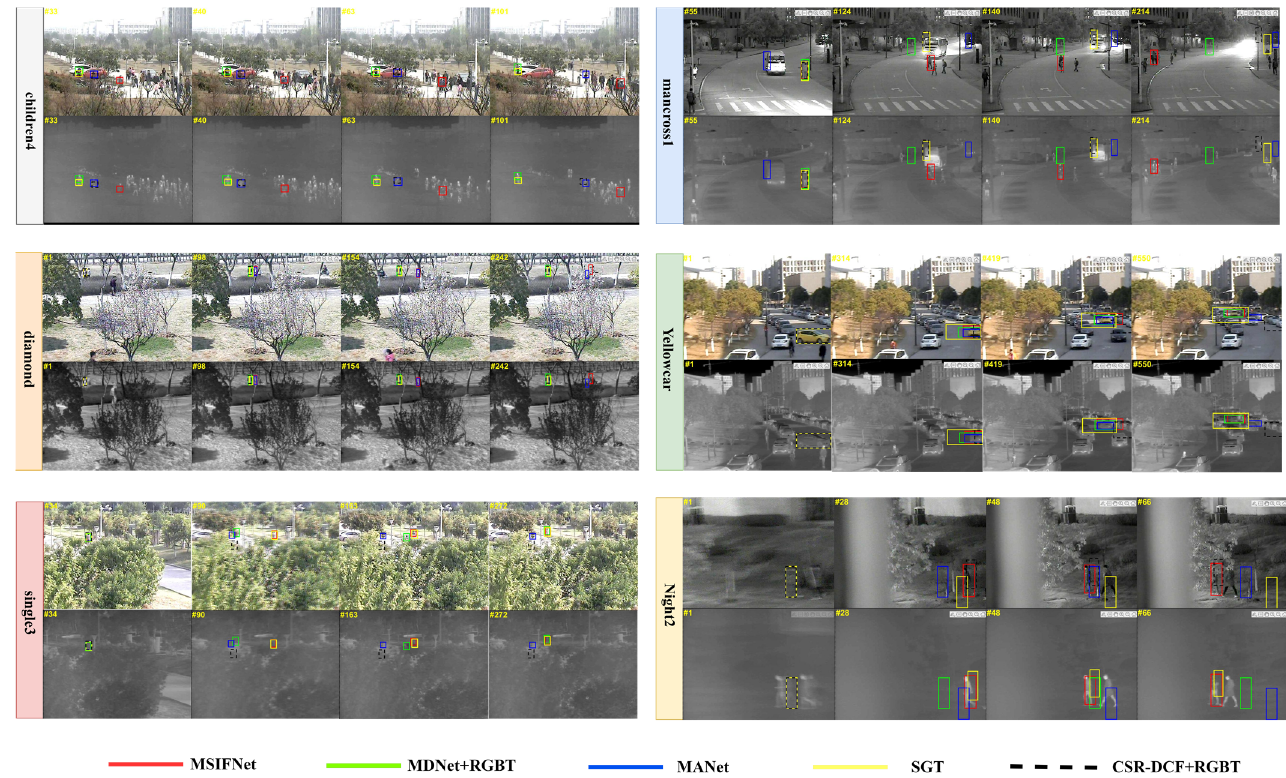
Figure 10. Qualitative comparison with four excellent RGBT trackers.